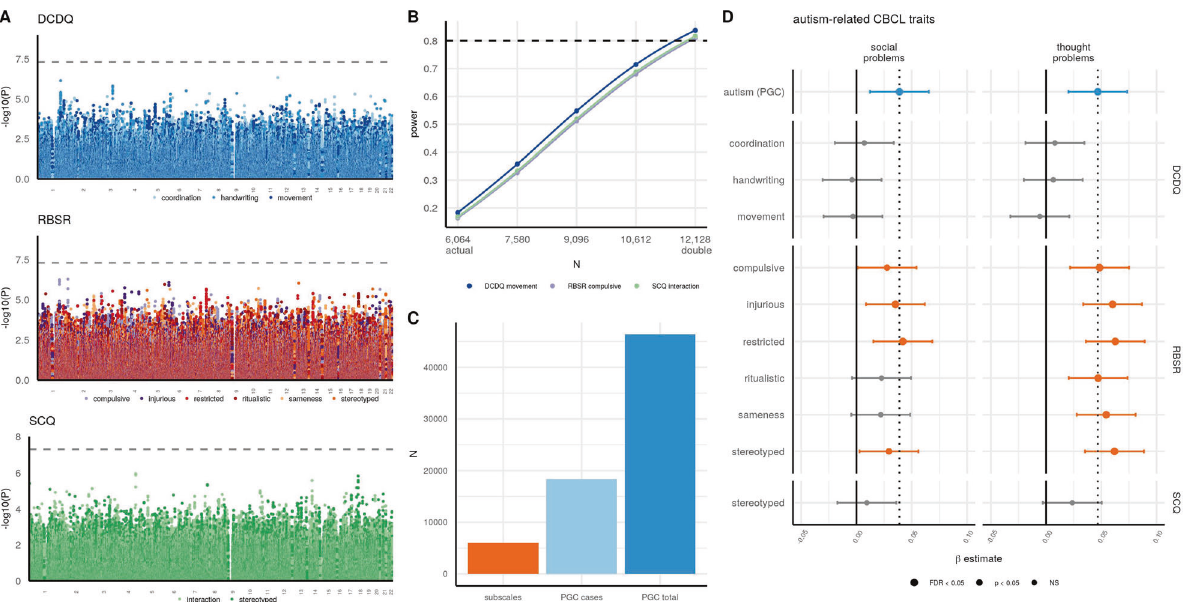
Fig. 4 Subscale GWAS in SPARK and PGS estimations in ABCD associated with autism-related traits. A Manhattan plots for the GWAS of the subscales. The dashed line is the genome-wide signi fi cance line at − log 10 (5 × 10 − 8 ). B Clumped lead SNPs ( p < 5 × 10 − 4 ) for each GWAS were used to calculate power at sample sizes ranging from N = 6064 (actual sample size) to N = 12,128 (double sample size). For each psychometric instrument/core domain, the subscale with the lowest power at N = 12,128 is shown. C Sample sizes of the subscale GWAS in comparison to the autism (PGC) cases and the autism (PGC) cases and controls. D PGS estimations from the subscale GWAS and the autism (PGC) GWAS were calculated in ABCD and associated with two CBCL measures shown to be elevated in autistic individuals – social problems and thought problems [69]. The β estimate from the linear model is shown with the 95% con fi dence interval. The dashed line is the β estimate for the autism (PGC) PGS.